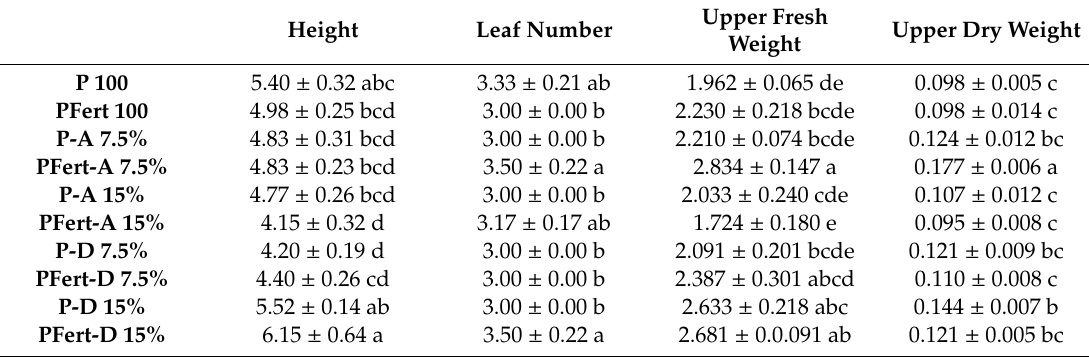
Table 4. E ff ects of peat (P 100) with di ff erent biochar types (A, D) and ratio (7.5%, 15%) and mineral doses (with standard or with additional Fertilizers-Fert.) on cabbage plant growth (height in cm, upper fresh weight in g, upper dry weight in g, root length in cm). Upper Height Leaf Number